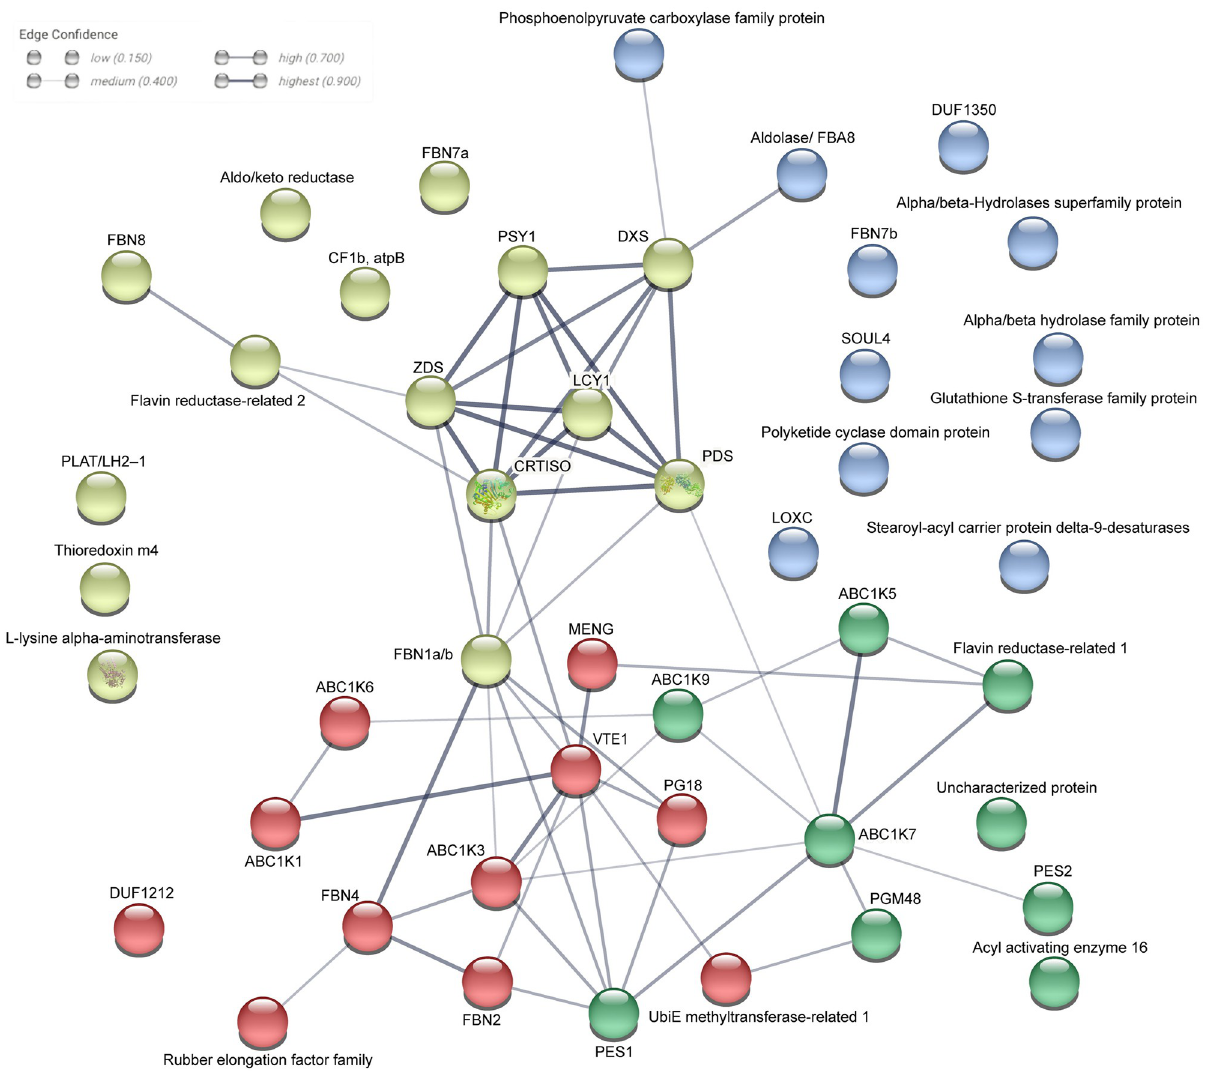
Fig 4. Interaction network of chromoplast PG proteins. The tomato chromoplast PG proteome analysis using the STRING software identified three clusters. Pear, (cluster 1) enriched in carotenoid biosynthetic enzymes; Red, (cluster 2) enriched in prenyl quinone metabolism and regulation; green, (cluster 3) enriched in chloroplast senescence and thylakoid membrane dismantling; blue, proteins not associated with the network.